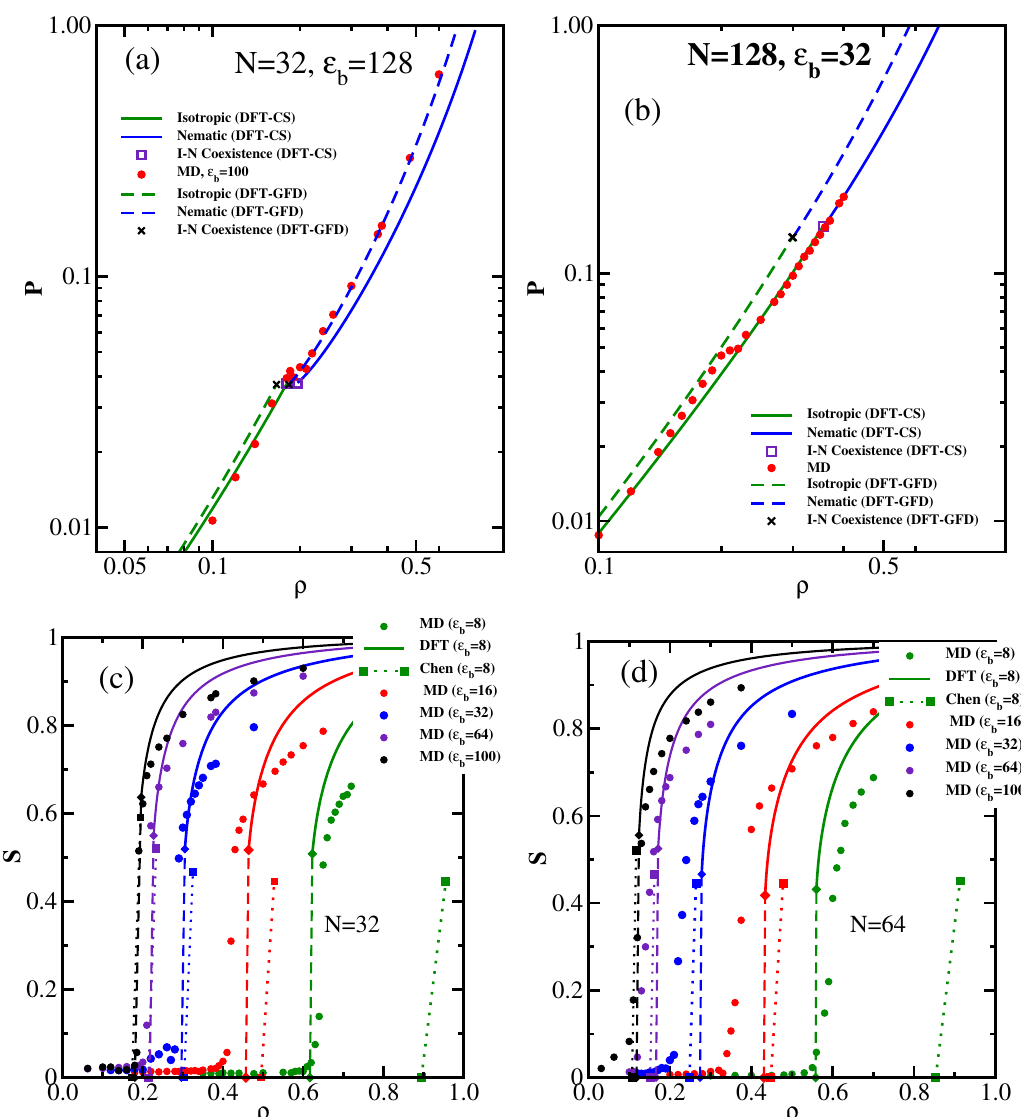
Figure 1. ( a ) Pressure P vs. density ρ for semiflexible chains with N = 32 beads and (cid:101) b = 128. Due to the choice of units σ = 1, (cid:101) = 1, k B T = 1, both P and ρ are dimensionless. Circles represent MD data, while curves denote the corresponding DFT-CS and DFT-GFD predictions, as indicated. Open squares and crosses indicate coexistence conditions; ( b ) Same as (a), but for N = 128 and (cid:101) b = 32; ( c ) Order parameter as a function of density for semiflexible chains of length N = 32 and various choices of (cid:101) b , as indicated. Circles are MD results, curves are DFT-CS predictions for S ( ρ ) , ending at S ( ρ n ) = S c (diamonds), while the linear variation in the I-N coexistence region is shown by dashed straight lines. The corresponding predictions from Chen [20] for the I-N coexistence region are shown by dotted straight lines, ending in squares; ( d ) Same as (c), but for N = 64. Reproduced from [43] with permission from the Royal Society of